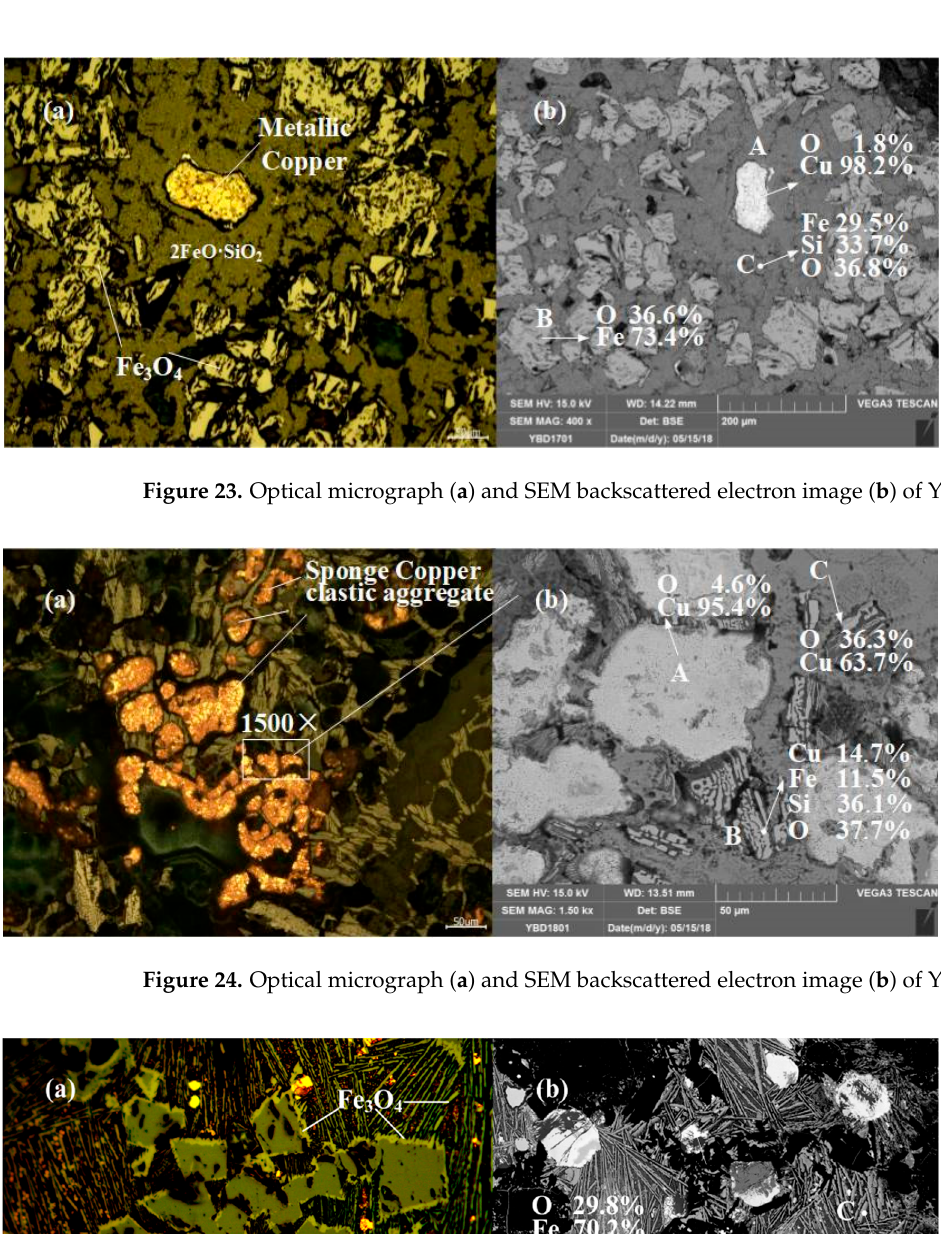
Figure 25. Optical micrograph ( a ) and SEM backsca tt ered electron image ( b ) of YBD20. Sample YBD22: Metallic copper particles were detected under examination using optical microscopy enveloped by oxidized copper ore. As shown in Figure 26.